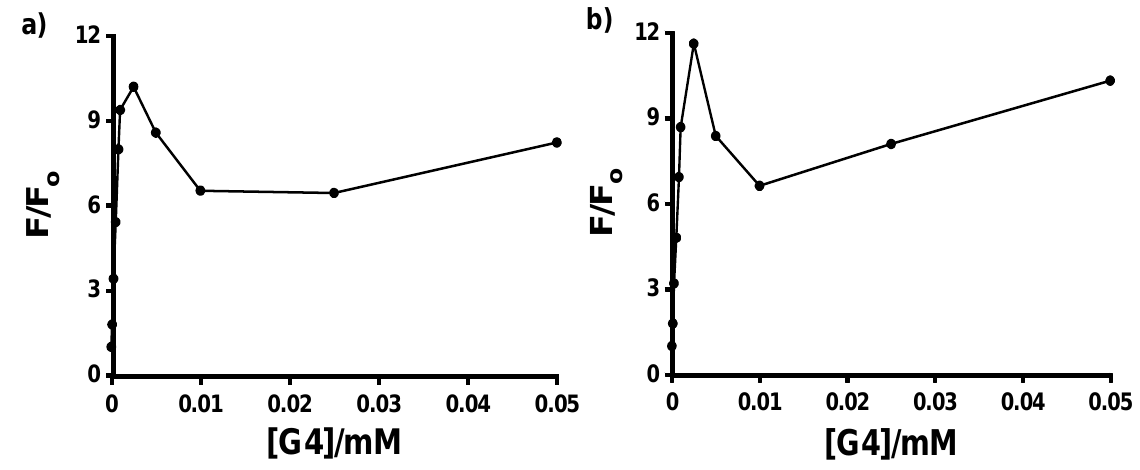
Figure 7. Expansion of the low host-concentration region of the averaged host fluorescence titration plots for 4 × 10 -5 M a) 1,8-ANS and b) 2,6-ANS as a function of G4 PAMAM dendrimer concentration {from Figure 4 a and b)}, illustrating the anomalous spike in fluorescence